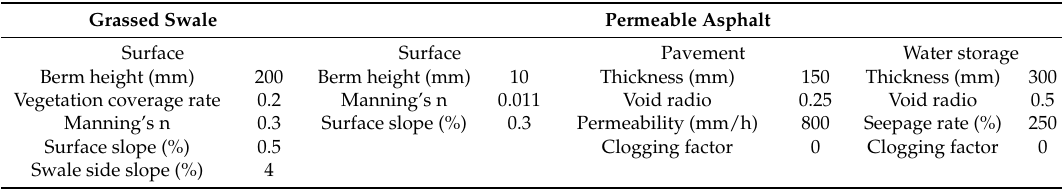
Table 1. Table of parameters of LID